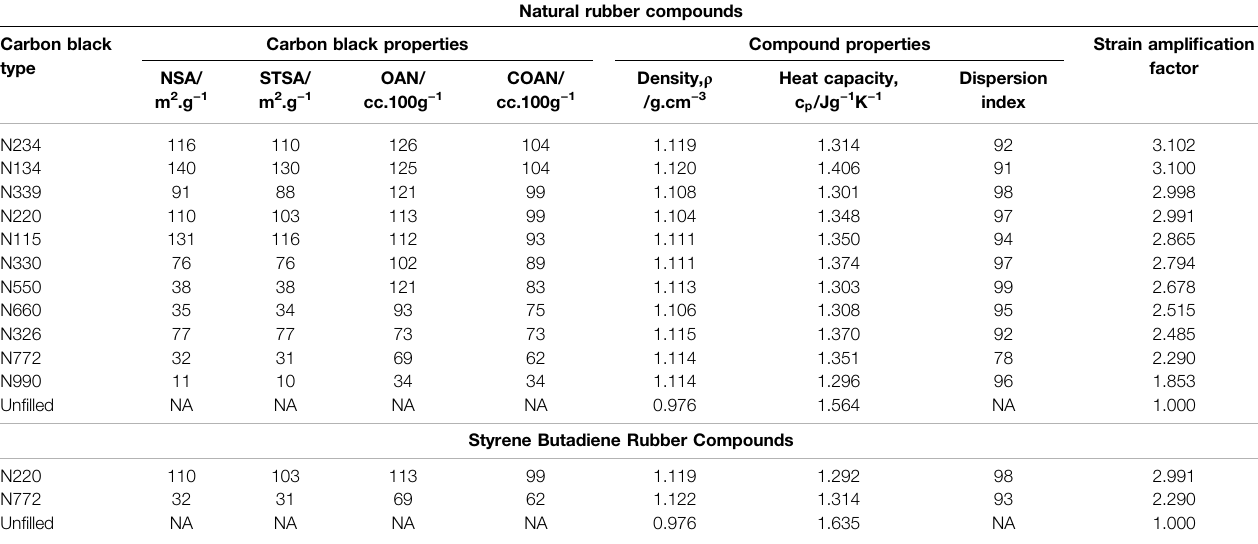
Natural rubber compounds